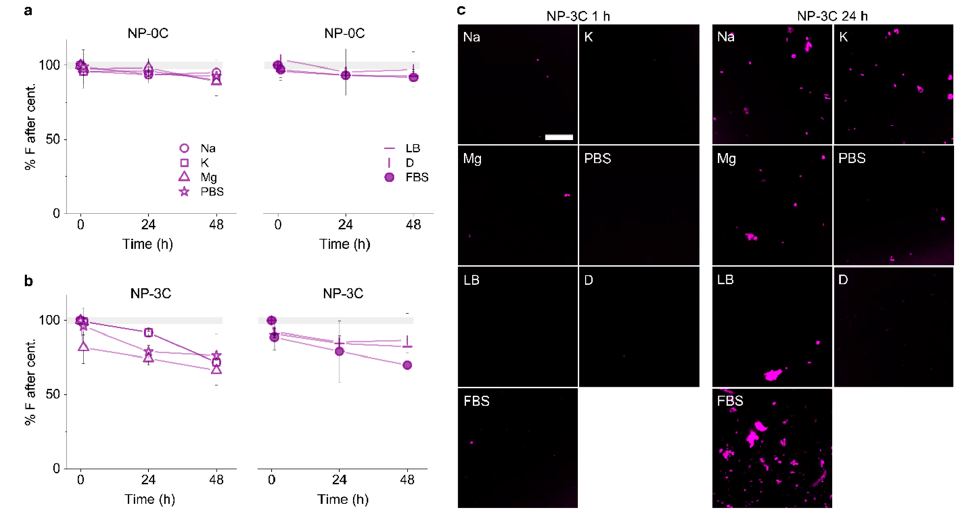
Figure 4. Identifying aggregation of DNA nanopores over time. Relative fluorescence intensities of Cy3-labeled ( a ) NP-0C and ( b ) NP-3C remaining in solution after centrifugation at 1, 24, and 48 h, in the stated buffers; ( c ) CLSM images of Cy3-labeled NP-3C in the stated buffers at 1 and 24 h. Scale bar 50 µm.